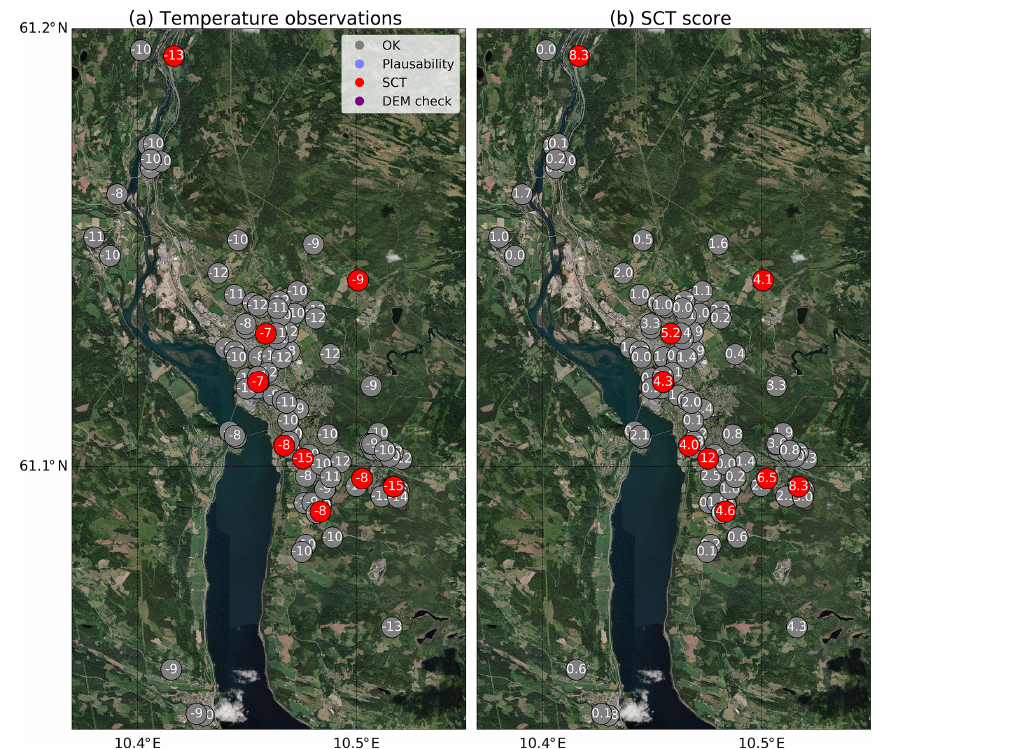
Figure 2. The result of the quality control by Titan for observations in Lillehammer for 06:00UTC on 5 November 2019, showing the temperature observations (a) with the corresponding SCT scores (b) . The observations passing the quality control are shown in grey, whereas those failing the plausibility check, the DEM check, or the SCT are shown in light purple, dark purple, and red, respectively. Background image source: ESRI World Imagery.